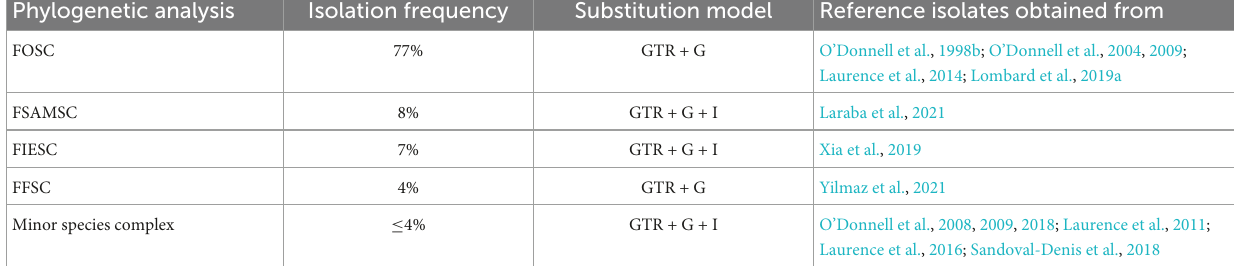
TABLE 1 The phylogenetic analyses for the identified species complexes and their substitution model and reference isolates sources